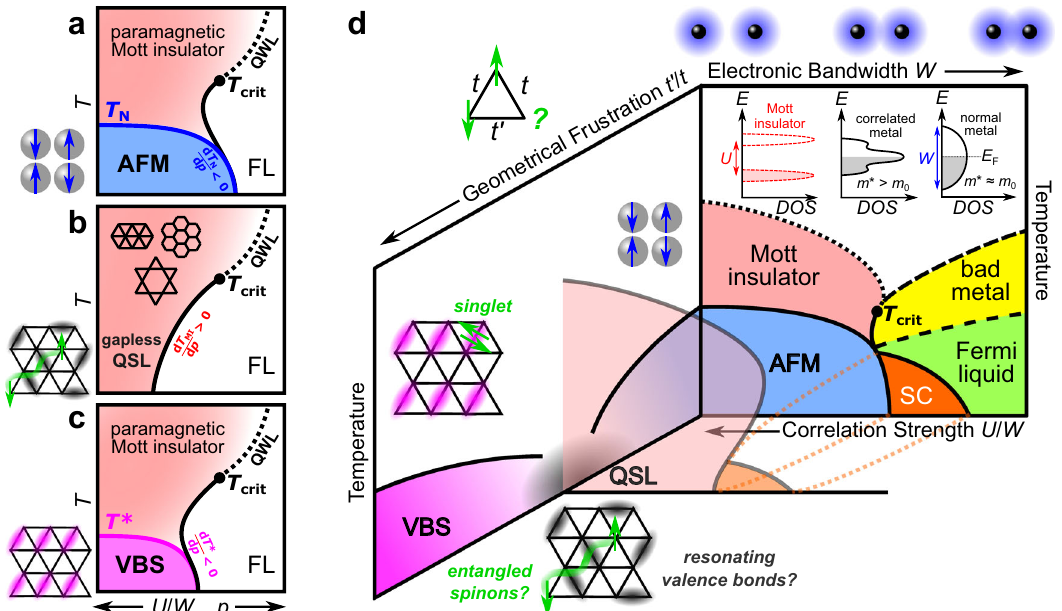
Fig. 1 | Phase diagram of Mott insulators as function of frustration and corre- lationstrength.a WhiletheentropyofaparamagneticMottinsulatorexceedsthat of the adjacent Fermi liquid (FL), resulting in a positive slope dT MI / dp >0 of the metal-insulator boundary, AFM order has much smaller entropy and the Clausius- Clapeyron relation yields dT N / dp <0, as seen in κ -(BEDT-TTF) 2 Cu[N(CN) 2 ]Cl 36,37 . b Nosuch'reentrance'ofinsulatingbehaviorisexpectedfora gapless QSL,possibly realized in triangular, kagome or honeycomb lattices 2,3 . c Similar to AFM, also the transition from a spin-gapped VBS insulator to a metal yields dT ⋆ / dp <0, for instance in EtMe 3 P[Pd(dmit) 2 ] 2 5,6 . d Geometrical frustration t 0 = t controls the